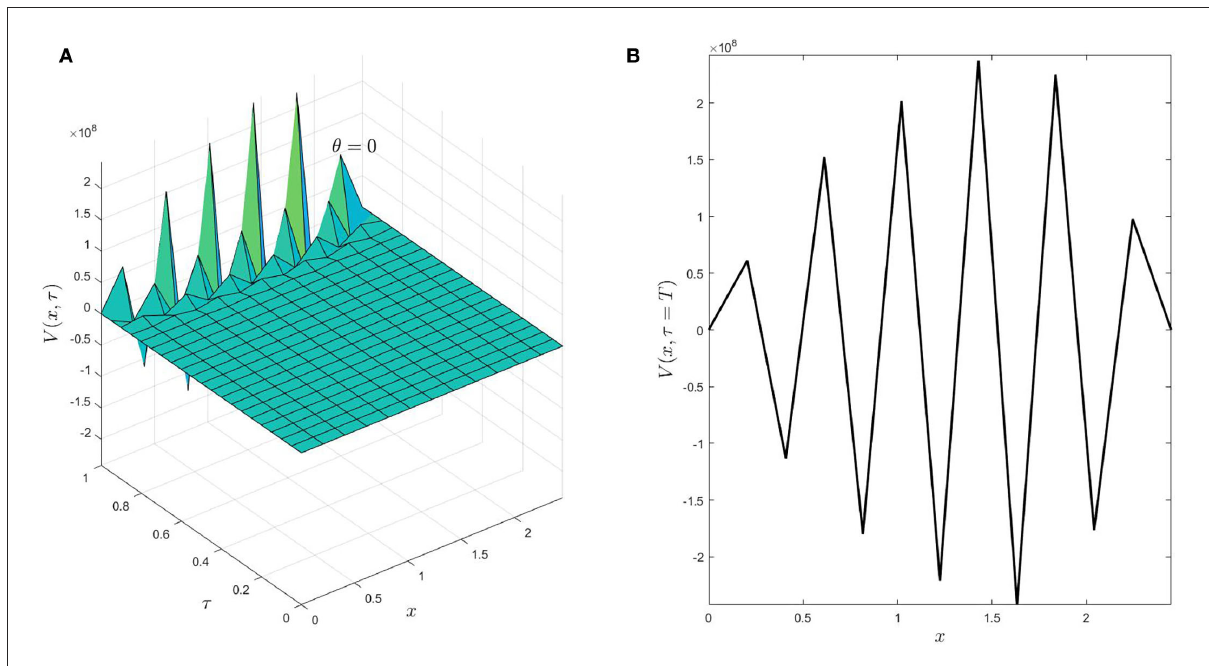
FIGURE9 (A,B) A 3D surface of numerical solutions and a 2D-cross section for τ θ =